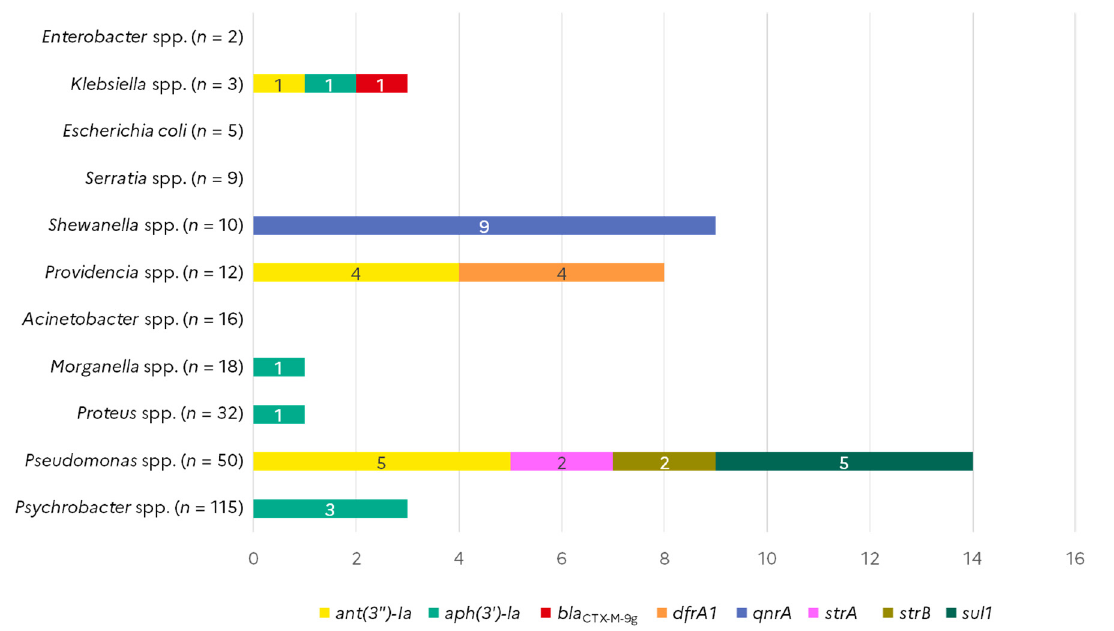
Figure 2. Occurrence of antimicrobial resistance genes in Gram-negative isolates from seafood ( N = 268).